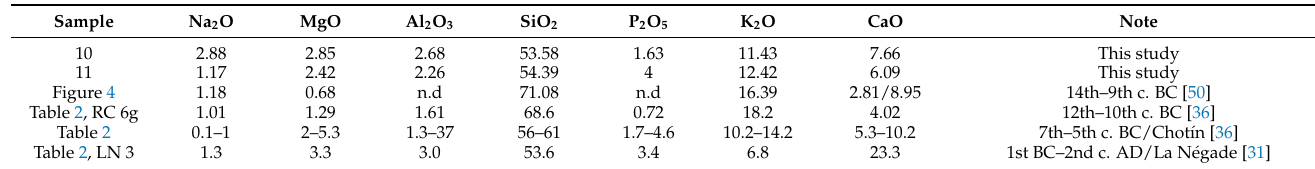
Table 2. Examples of Selected Oxides Represented in Potassium